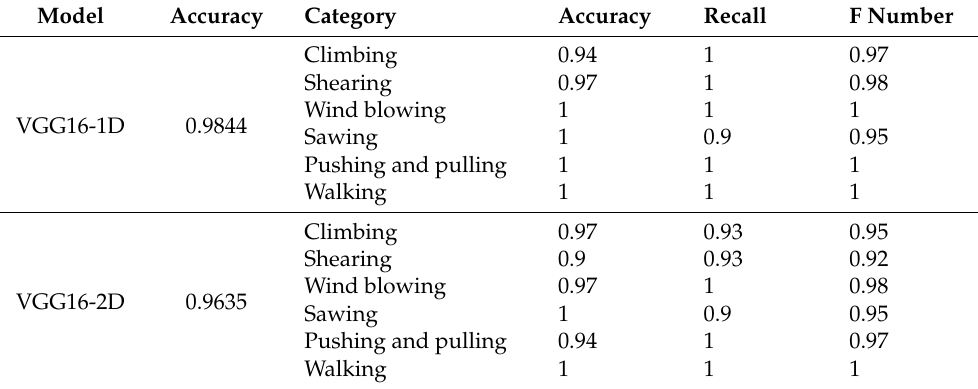
Table 2. Model identification results.